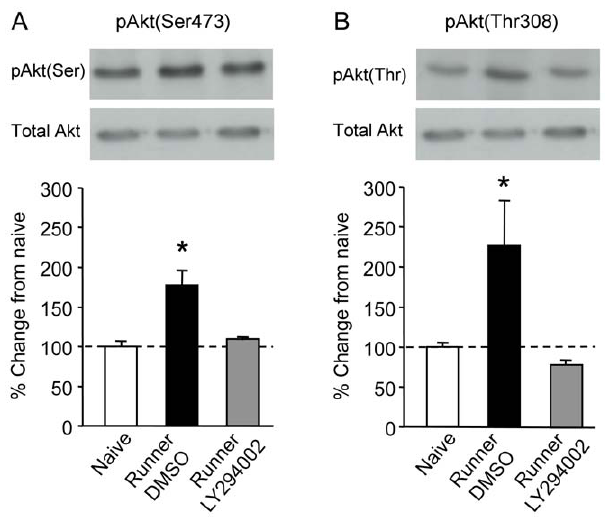
Figure 2. Regulation of pAkt in the dentate gyrus in exercising rats. A, Phosphorylation of Akt at serine site 473 and B, Akt phosphorylation at threonine site 308 in DMSO-treated runners (Black bars, n=4) is significantly greater than both LY294002-treated runners (Grey bars, n=4) and naı¨ve rats (White bars, n=4). Histograms represent the percent change in pAkt normalized to naı¨ve controls. PhosphoAkt levels at both sites in LY294002-treated runners are not significantly different from naı¨ve rats. Sample blots for each group are presented in upper panels. No change in total Akt was observed.